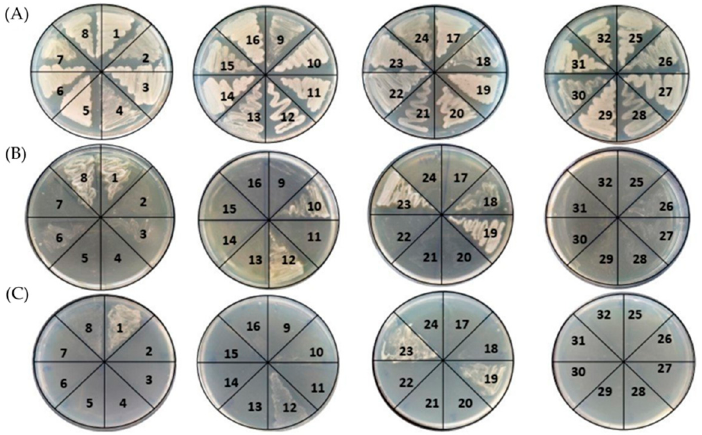
Figure 1. Growth of 32 yeast isolates under various growth temperatures at 37 °C ( A ), 40 °C ( B ), and 45 °C ( C ), respectively, on YM medium agar for 48 h. H1-H32 isolates were indicated as 1–32.